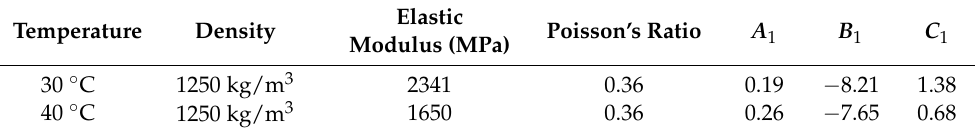
Table 1. Experimental parameters of FFF 3D printed PLA tensile samples.